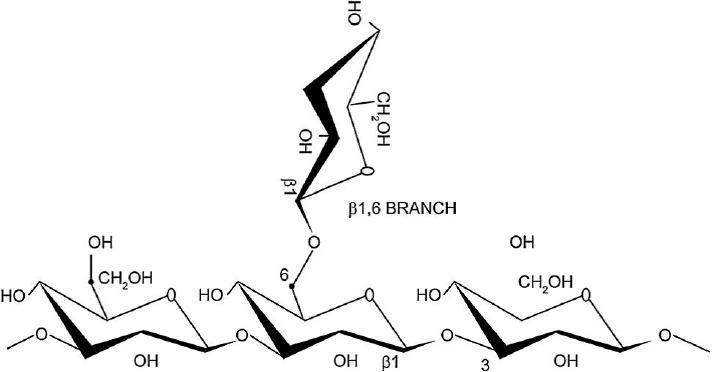
Figure 1. A linear 1,3 glycosidic chain of β - D -glucose monomers linked by a 1,6 glycosidic bond [11].